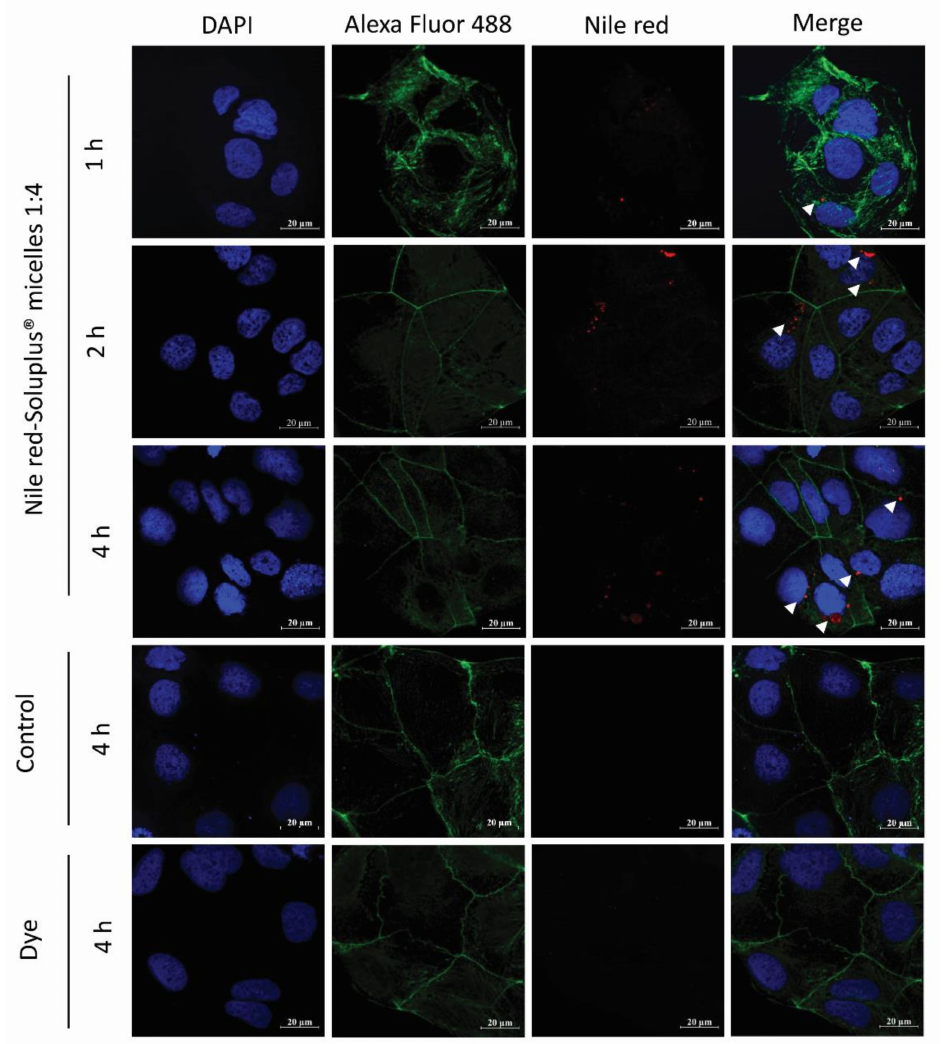
Figure 10. Confocal laser scanning microscopy images of Caco-2 cells with NR-PM (1:4); arrowheads indicate the presence of the micelles within the cells. Red: NR-PM, blue: nucleus, green: cell membrane. Magnification 40 × ; scale bar = 20 µ